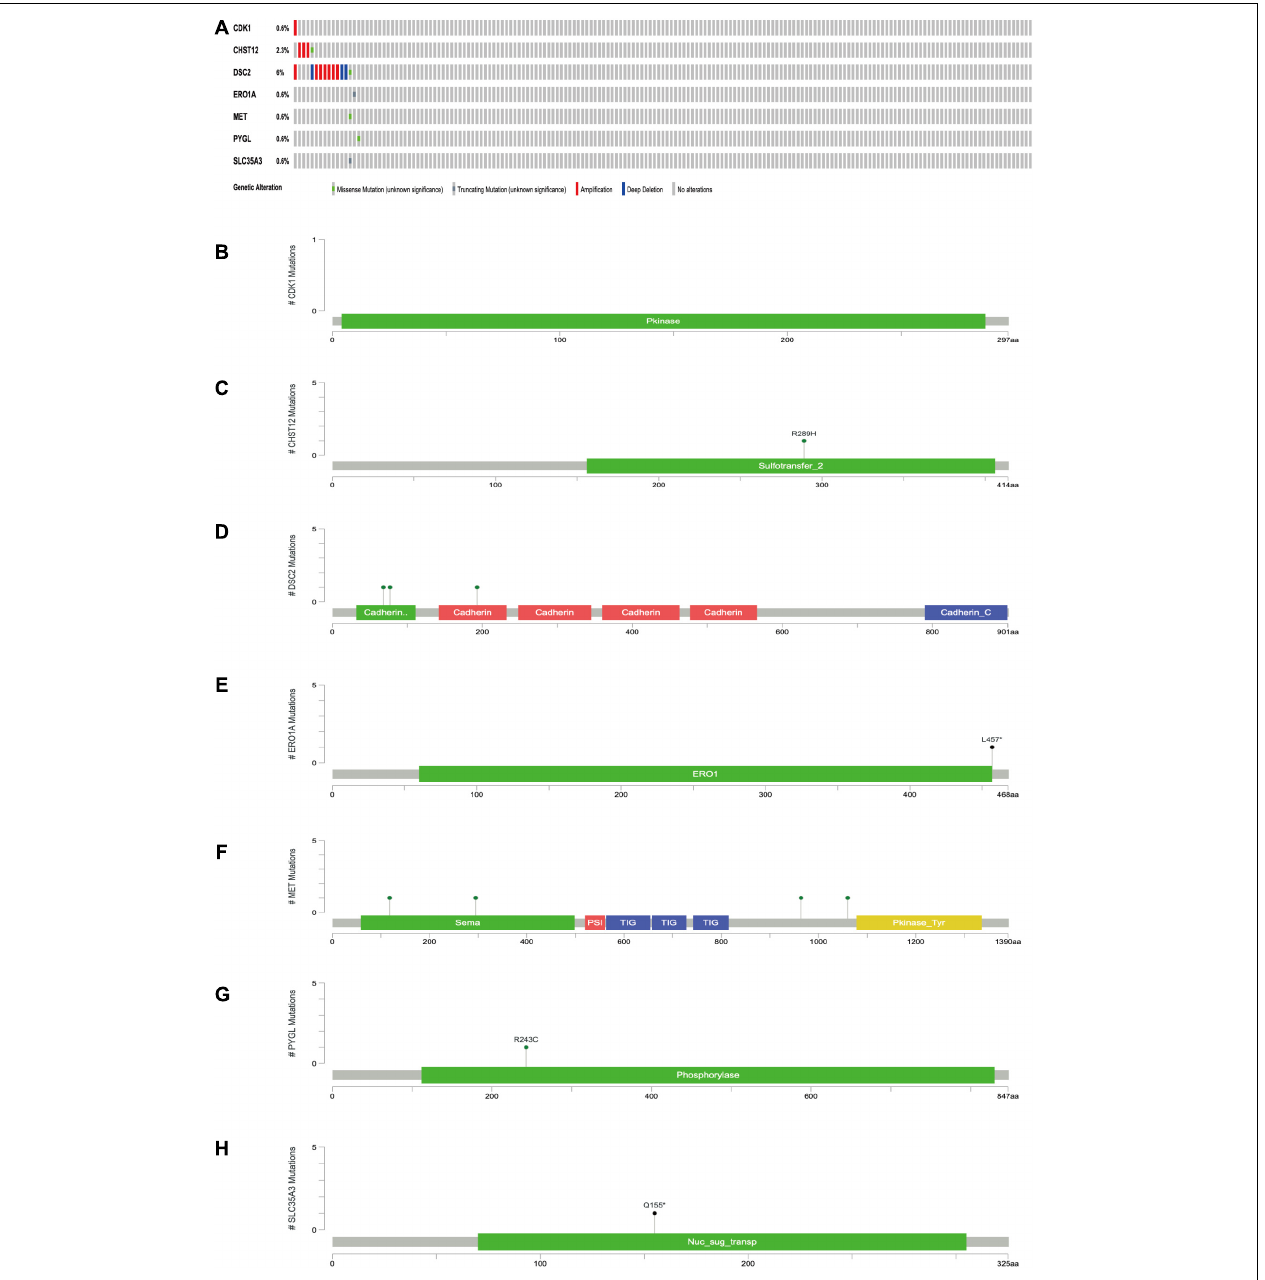
FIGURE 8 | (A) Mutations of model genes. (B) Mutation of CDK1. (C) Mutation of CHST12. (D) Mutation of DSC2. (E) Mutation of ERO1A. (F) Mutation of MET. (G) Mutation of PYGL. (H) Mutation of SLC35A3. * p <